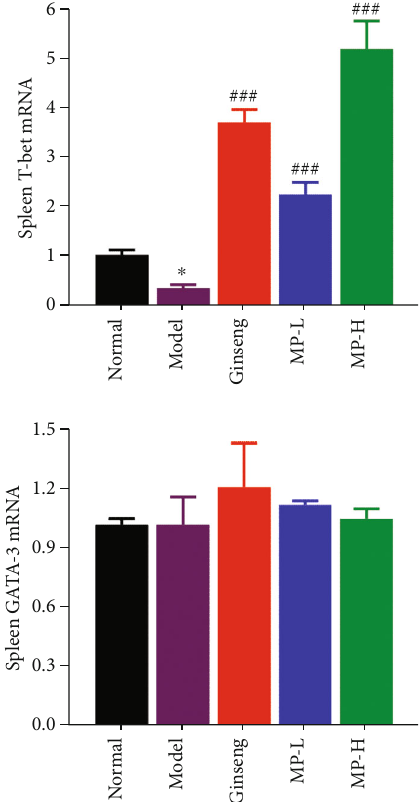
Figure 9: E ff ects of Maca polysaccharides on the mRNA expression of spleen T-bet and GATA-3 ( n = 12 ); ∗ p < 0 : 05 vs. control group; ## p < 0 : 01 and ### p < 0 : 001 vs. model